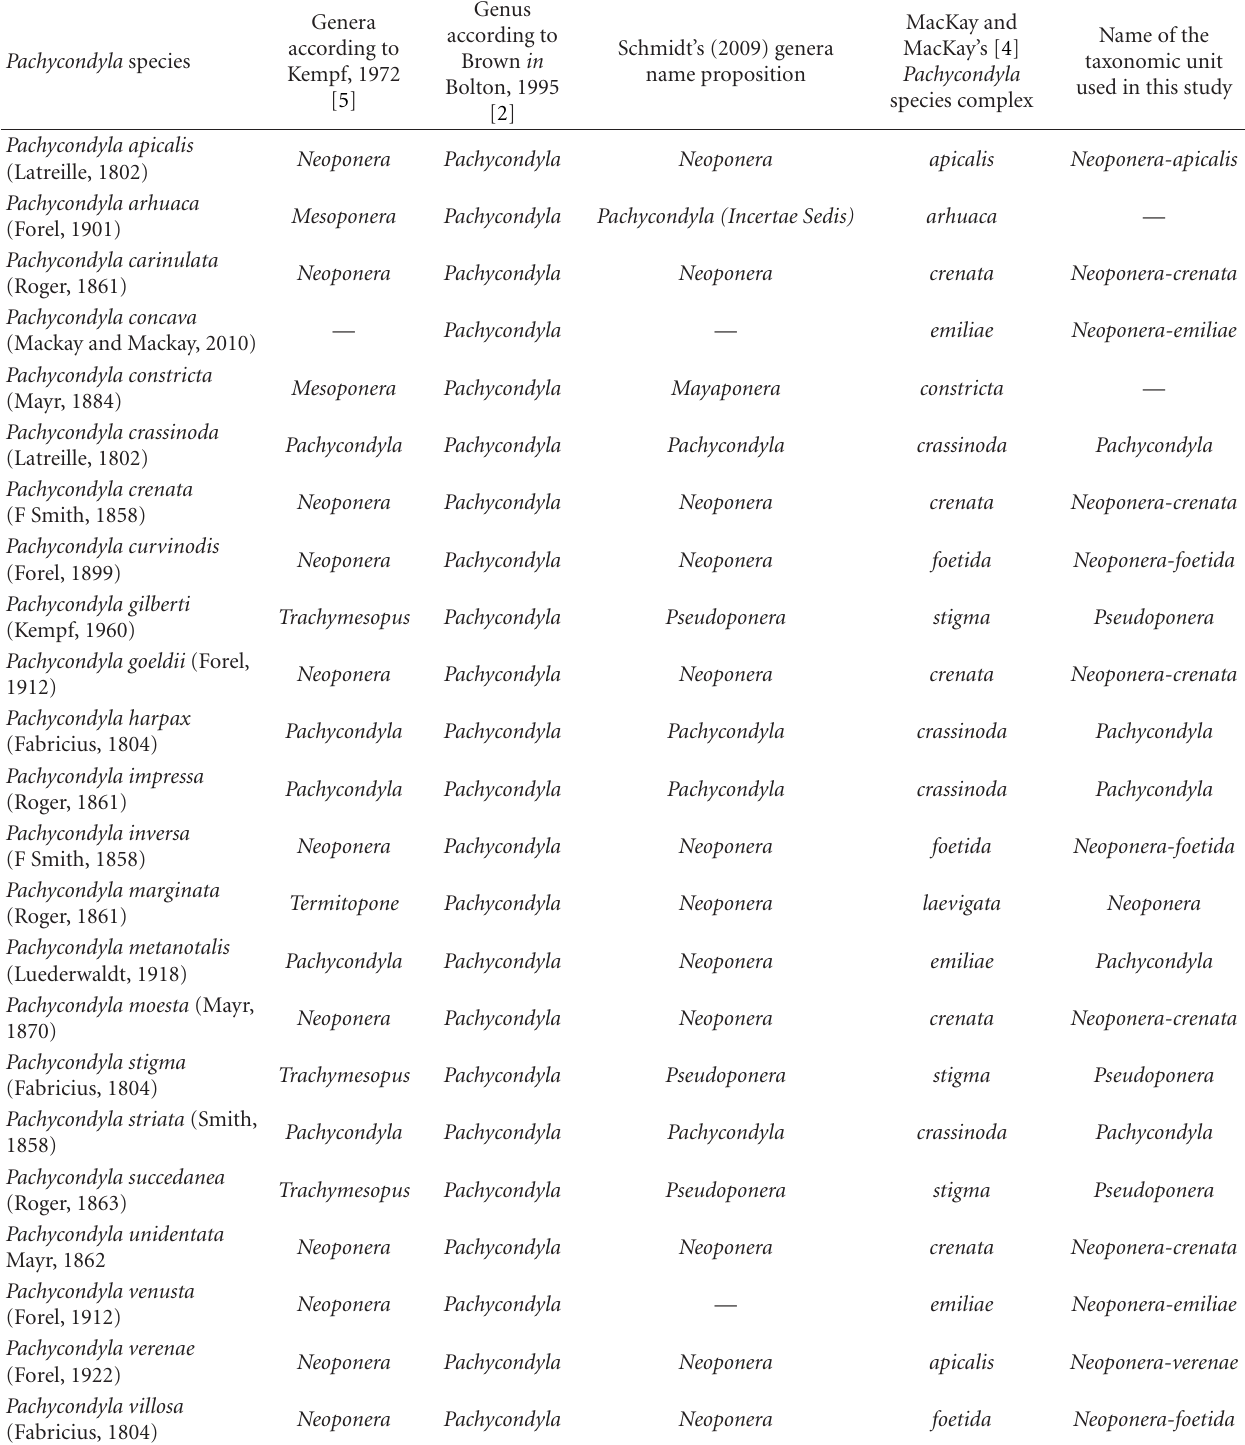
Table 1: List of species considered here, generic classification according to Kempf, 1972 [5]; Brown [6] in Bolton, 1995 [2]; Schmidt’s (2009) proposition for genera names; Pachycondyla species complex according to MacKay and MacKay’s [4] and taxonomic unit names used in this study and based on ecological, cytogenetic, and morphological